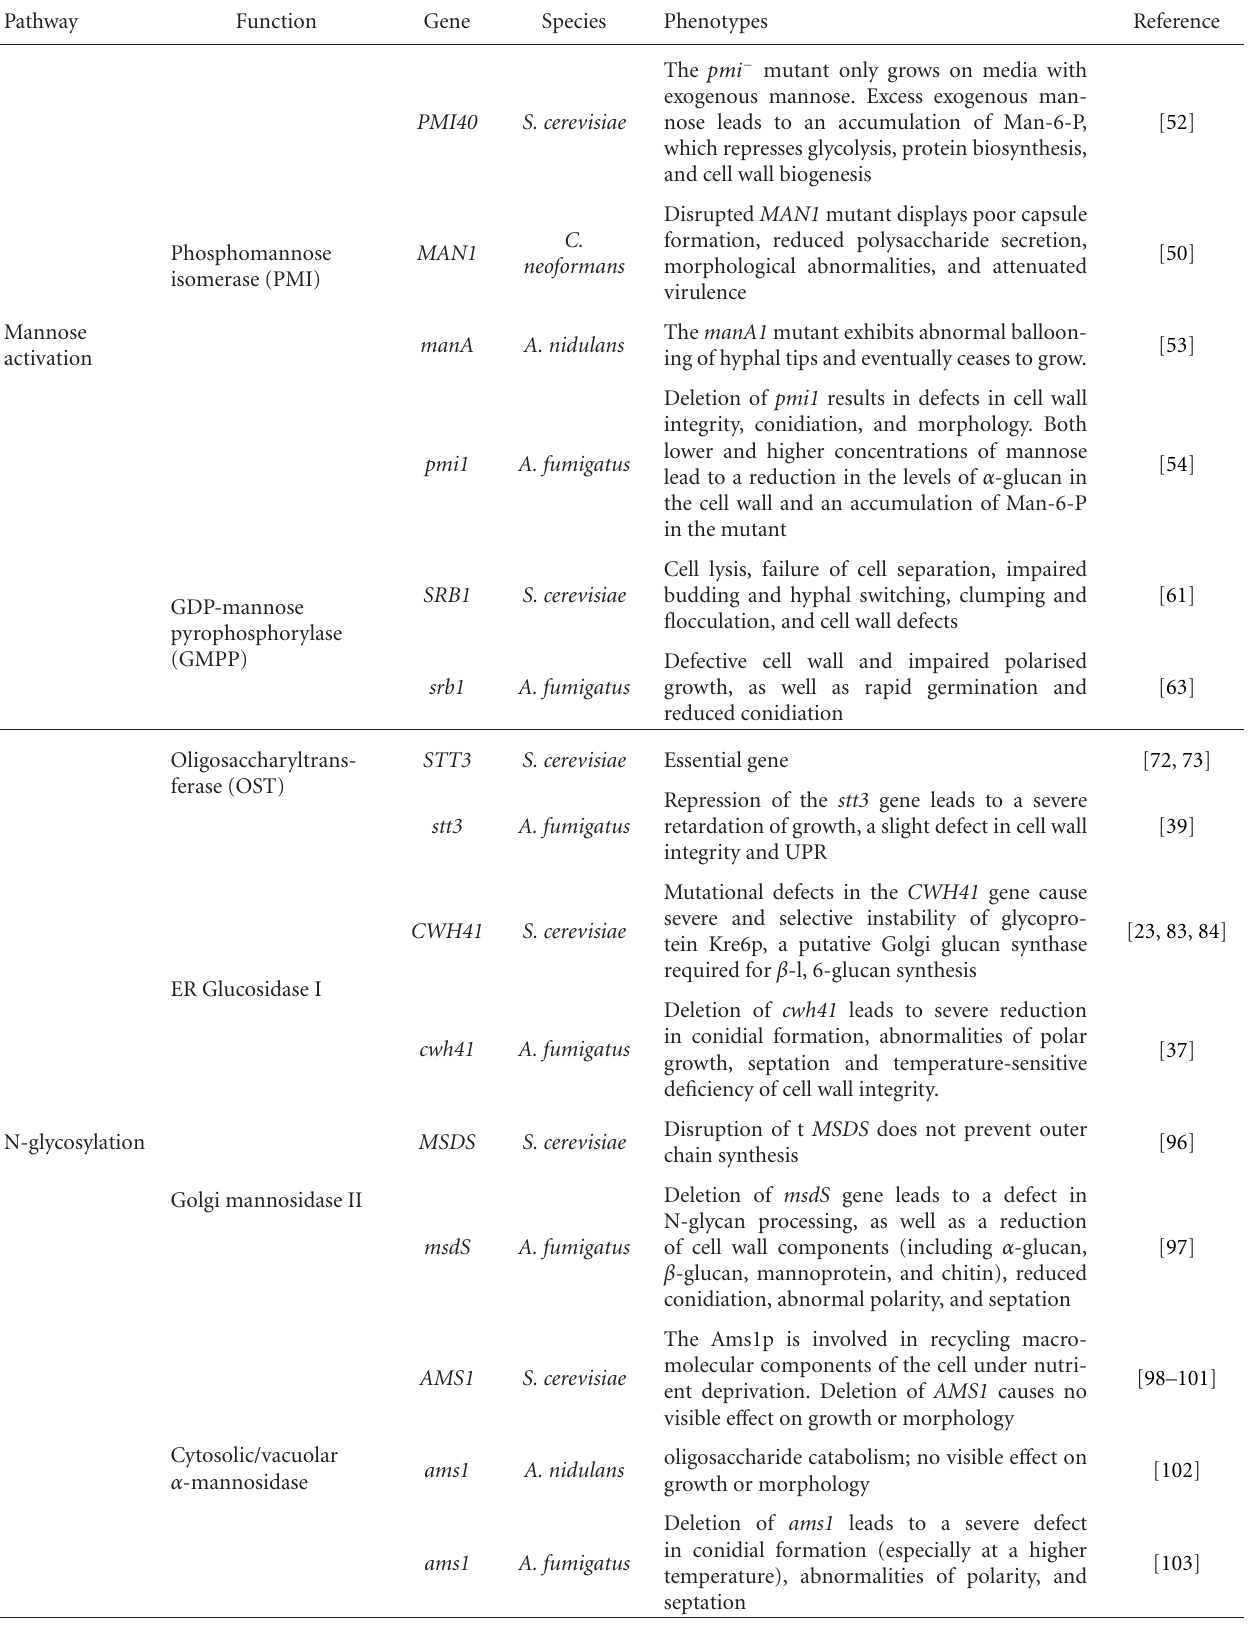
Table 2: Summary of the fungal genes studied in glycosylation